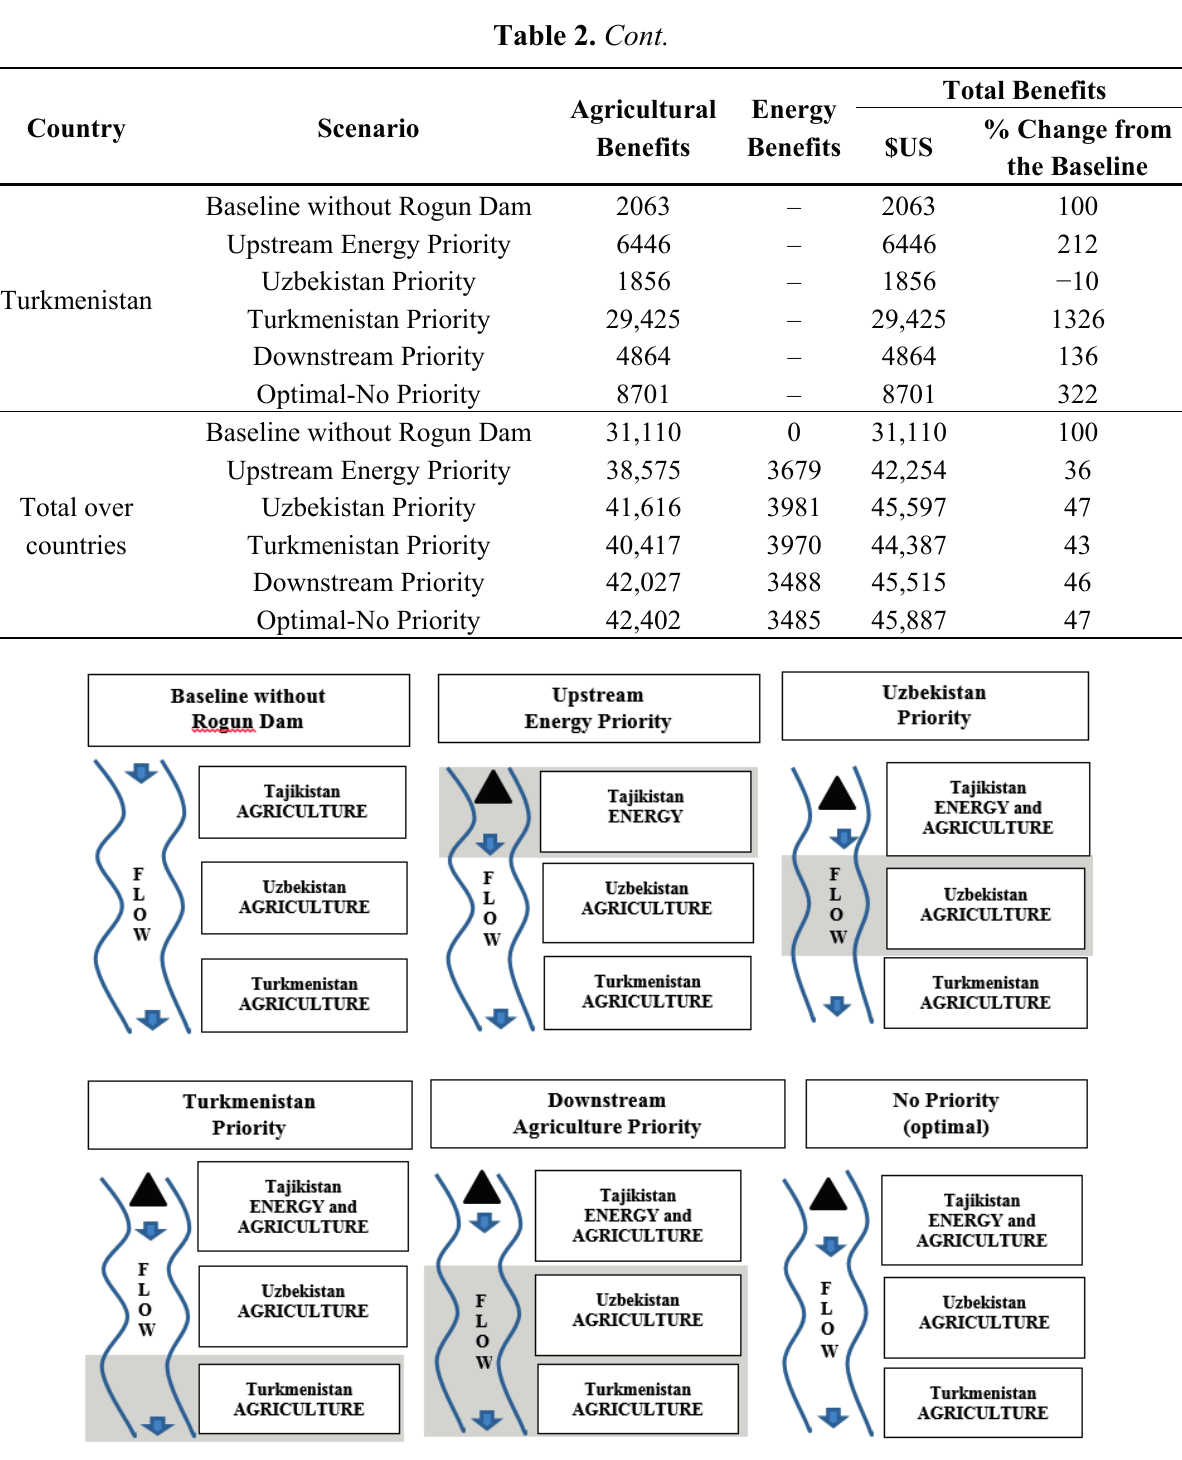
Figure 3. The scenarios modeled in the framework. Shaded area indicates the priority under each scenario, while black triangle indicates the Rogun